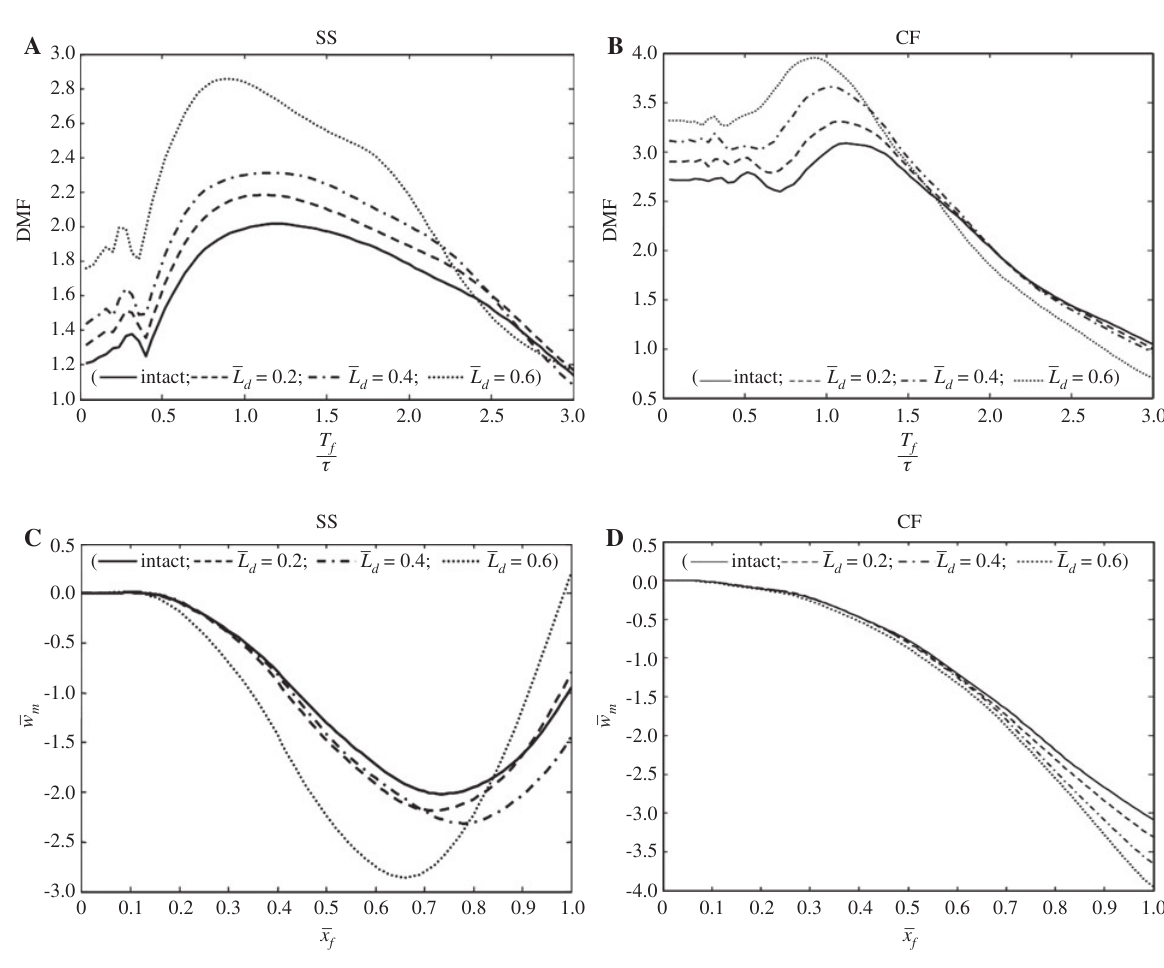
Figure 6 (A, B) Variation of DMF vs. T at load critical velocity (